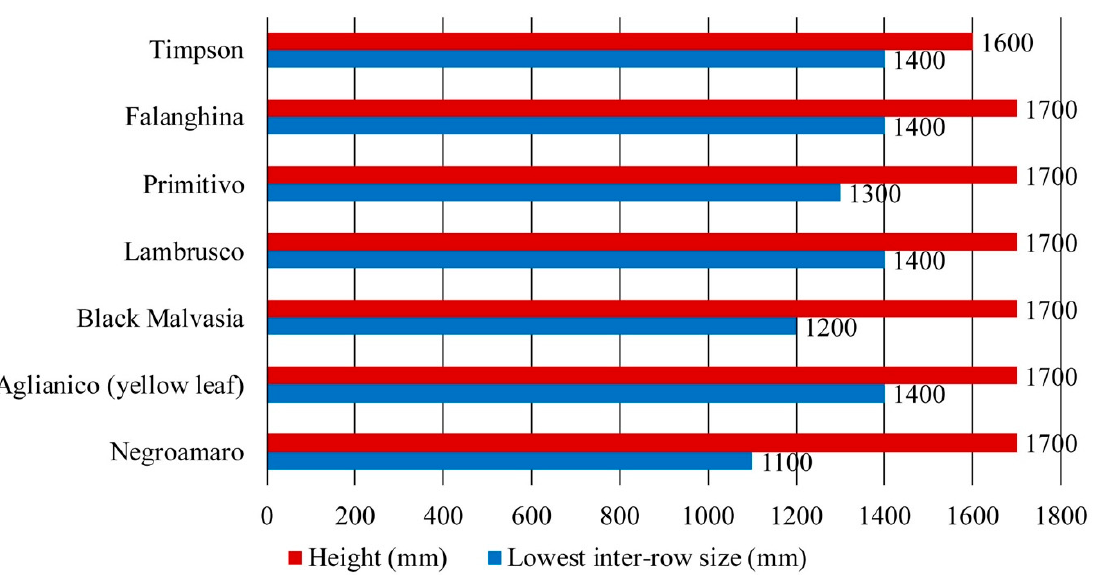
Figure 6. Average height and minimum width of the inter-row for each considered cultivar.